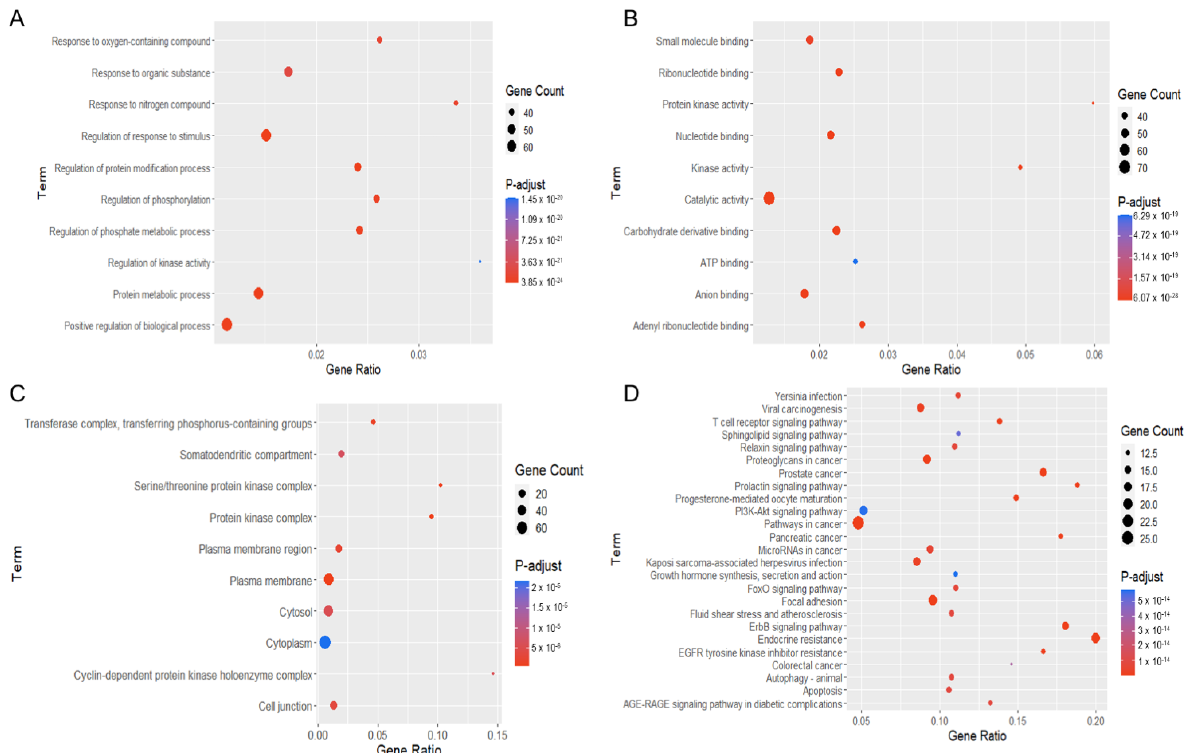
Figure 6. Gene ontology (GO) and Kyoto Encyclopedia of Genes and Genomes (KEGG) pathway enrichment analyses of potential targets of 22-(4 (cid:48) py)-JA against non-small-cell lung cancer (NSCLC). The encoded data obtained from the STRING database were constructed as a graphic using RStudio with the ggplot2 plugin. The GO terms consist of ( A ) biological process, ( B ) molecular function and ( C ) cellular component. ( D ) The KEGG pathway of potential target genes of 22-(4 (cid:48) py)-JA in NSCLC was